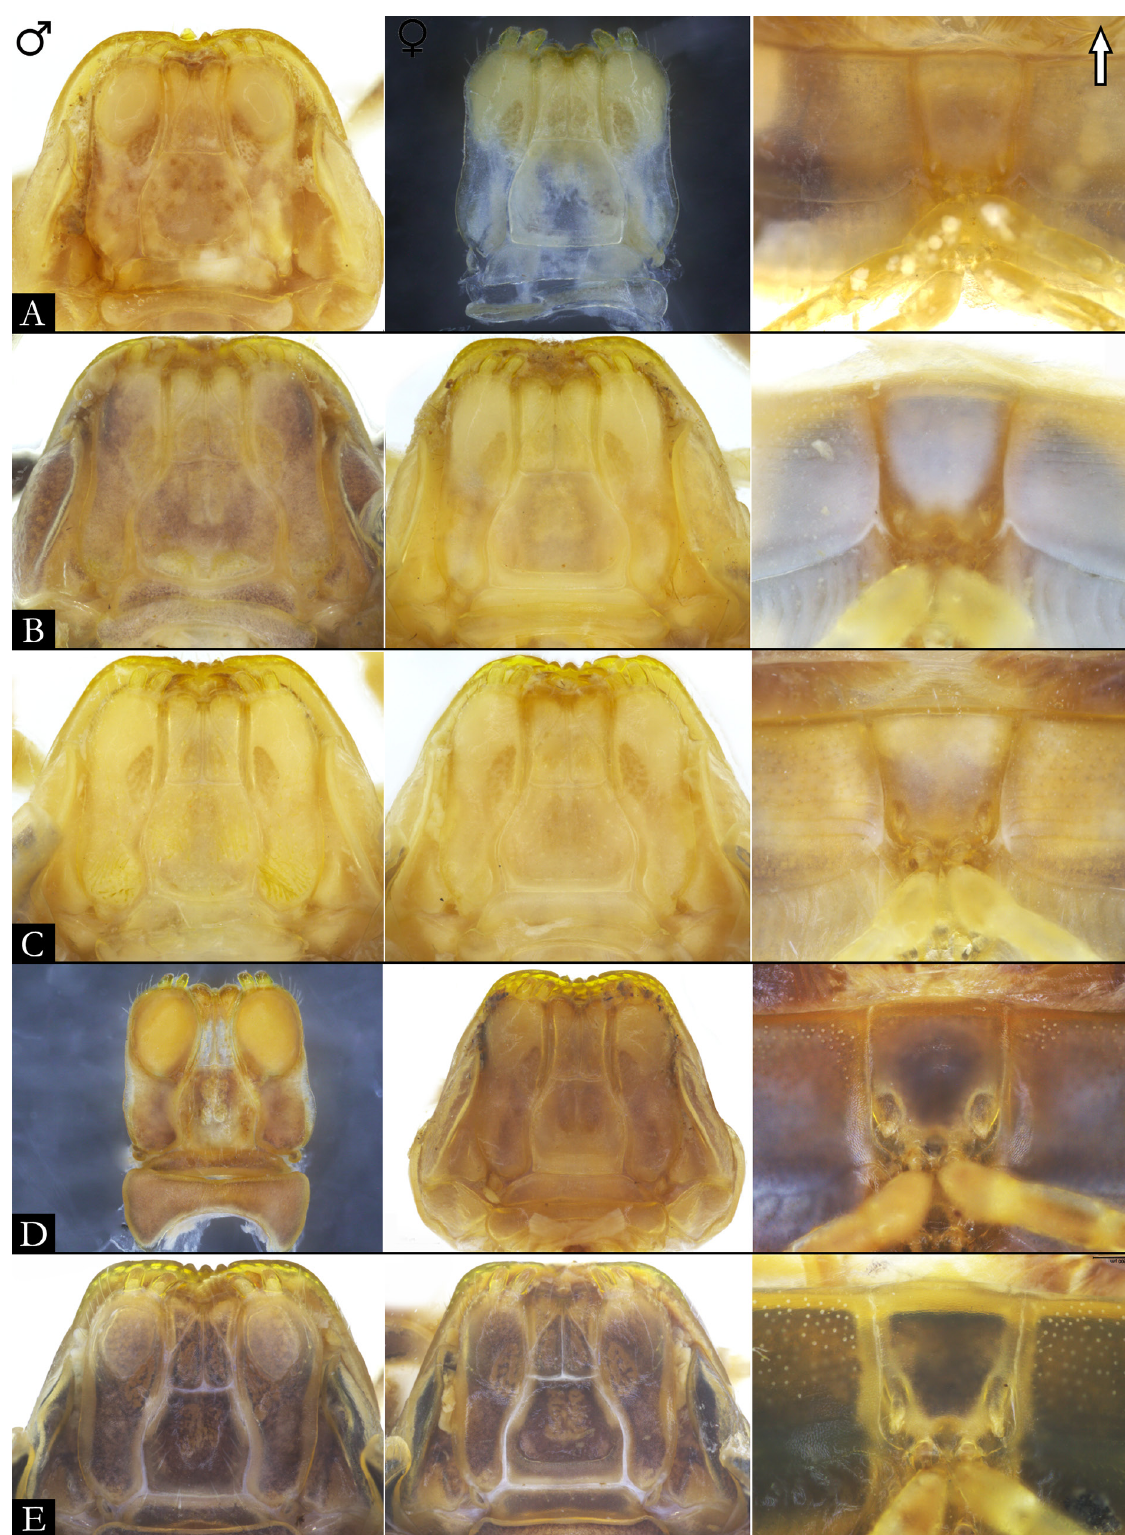
Fig. 174. Stereoscopic images of gnathochilarium and anterior sternum of species of Pseudonannolene Silvestri, 1895. A . P. xavieri Iniesta & Ferreira, 2014. B . P. bucculenta sp. nov. C . P. morettii sp.